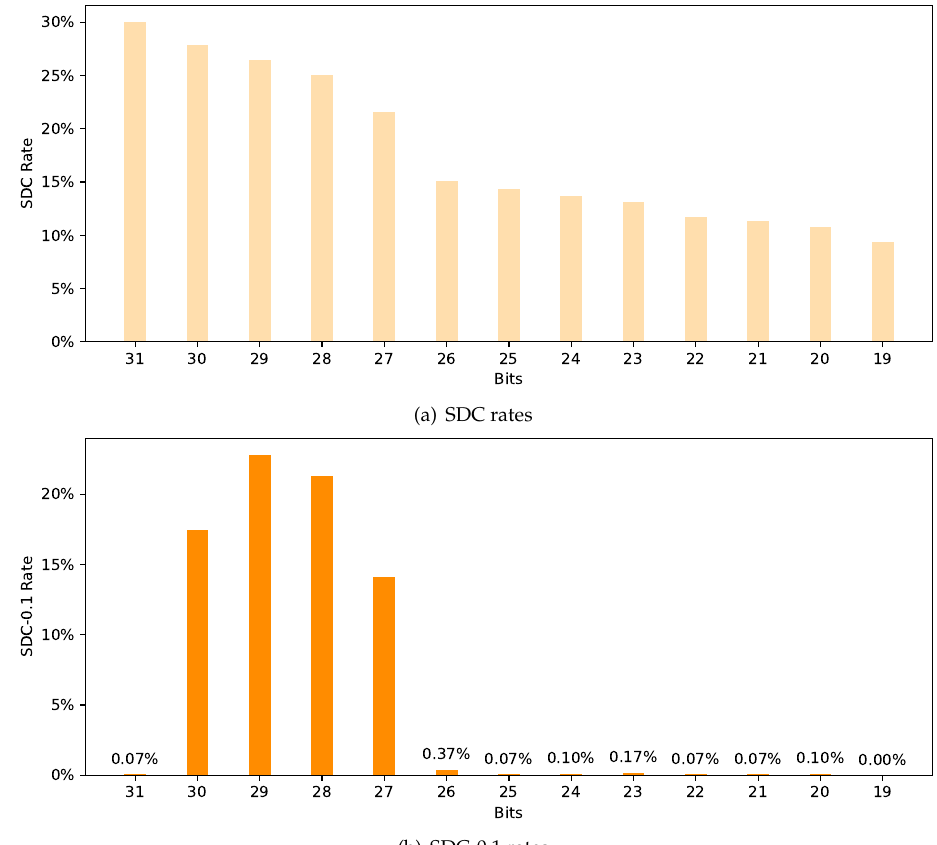
Figure 5. Feature map error injected in different bit positions in a SSD-VGG16 FLOAT model; sign bit (31), exponent bits (30-23) and high data bits of significand precision (22-19) are considered. (a) shows SDC rates for errors injected in various bit positions; (b) shows SDC-0.1 rates for errors injected in d various bit positions.